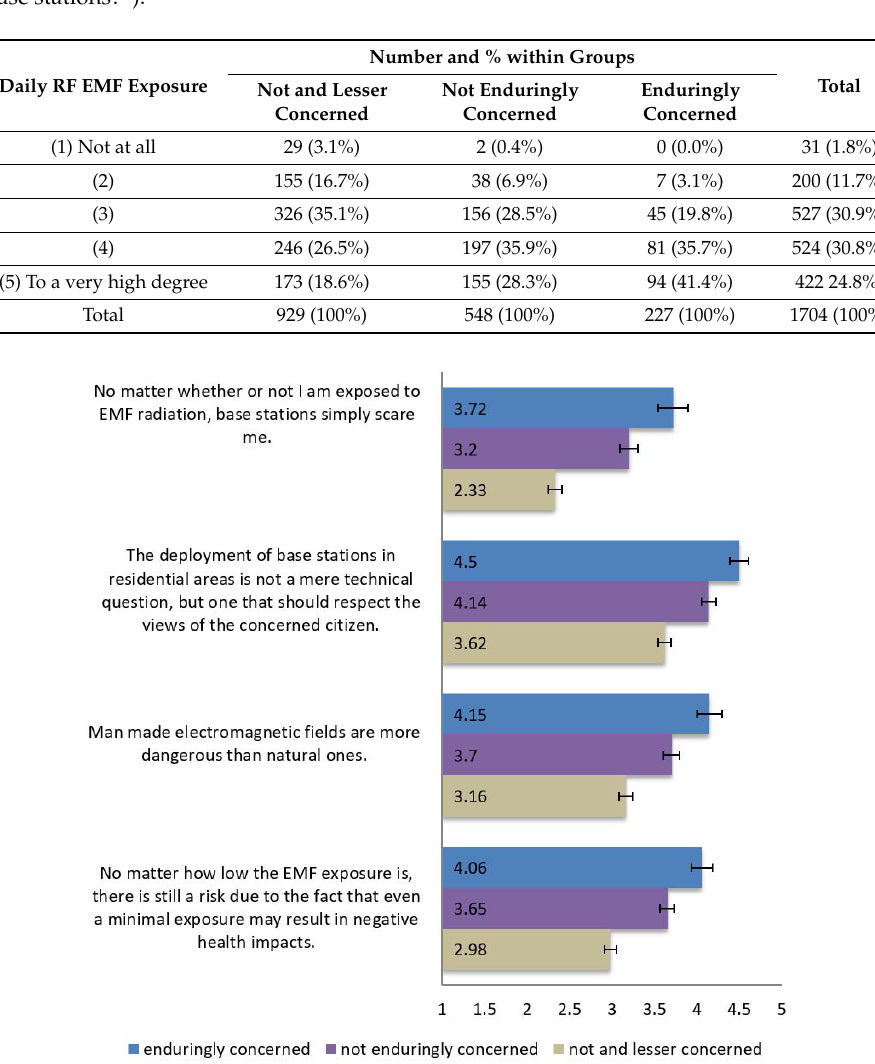
Table 2. Perceived level of daily radio frequency electromagnetic field (RF EMF) exposure per group (on a 5–point Likert scale from 1 “Not at all” to “5 “To a very high degree”) across the different manifestations of risk perception (Question: “Think about your daily life, to which degree do you think you are exposed to electromagnetic fields from electronic devices (such as mobile phones, WiFi router) and base stations?”).